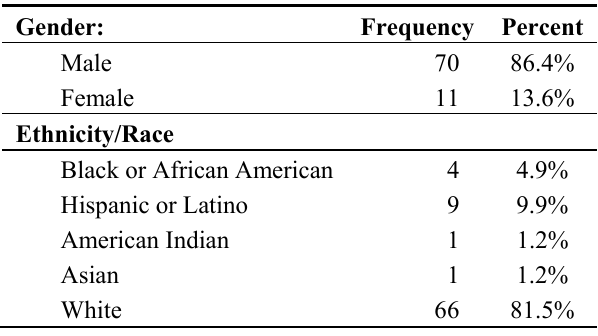
Table 2. Gender and ethnic breakdown of study sample.